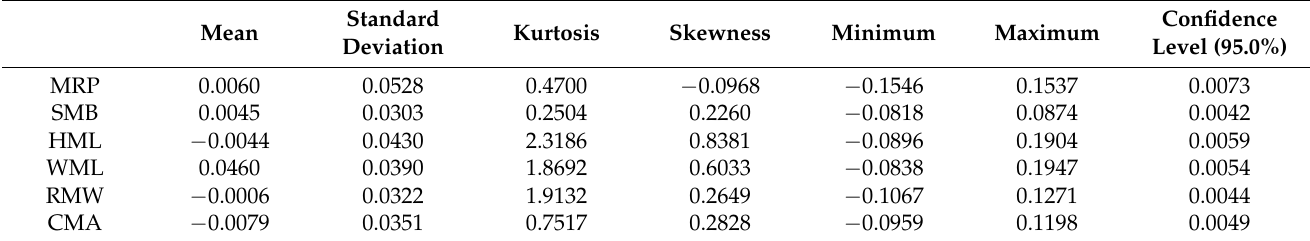
Table 4. Descriptive statistics of the asset pricing factor model